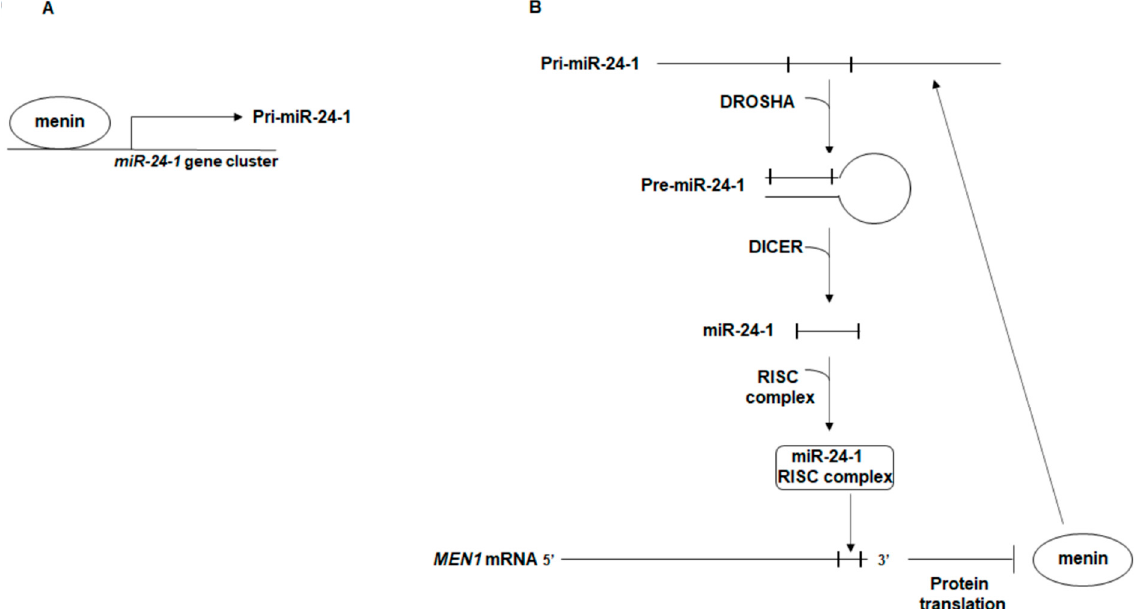
Figure 1. Schematic representation of the autoregulatory network between miR-24-1, MEN1 mRNA, and menin. ( A ) menin binds the upstream region of the miR-24-1-encoding gene cluster on chromosome 9, promoting the transcription of pri-miR-24-1; ( B ) menin directly interacts with the primary transcript of miR-24-1, pri-miR-24-1, facilitating the DROSHA-mediated processing to pre-miR-24-1, in a positive feedforward loop in which menin promotes the maturation of the repressor of its own expression, miR-24-1. Mature miR-24-1, together with the RISC complex, binds the 3 ′ UTR of MEN1 mRNA blocking translation of menin.